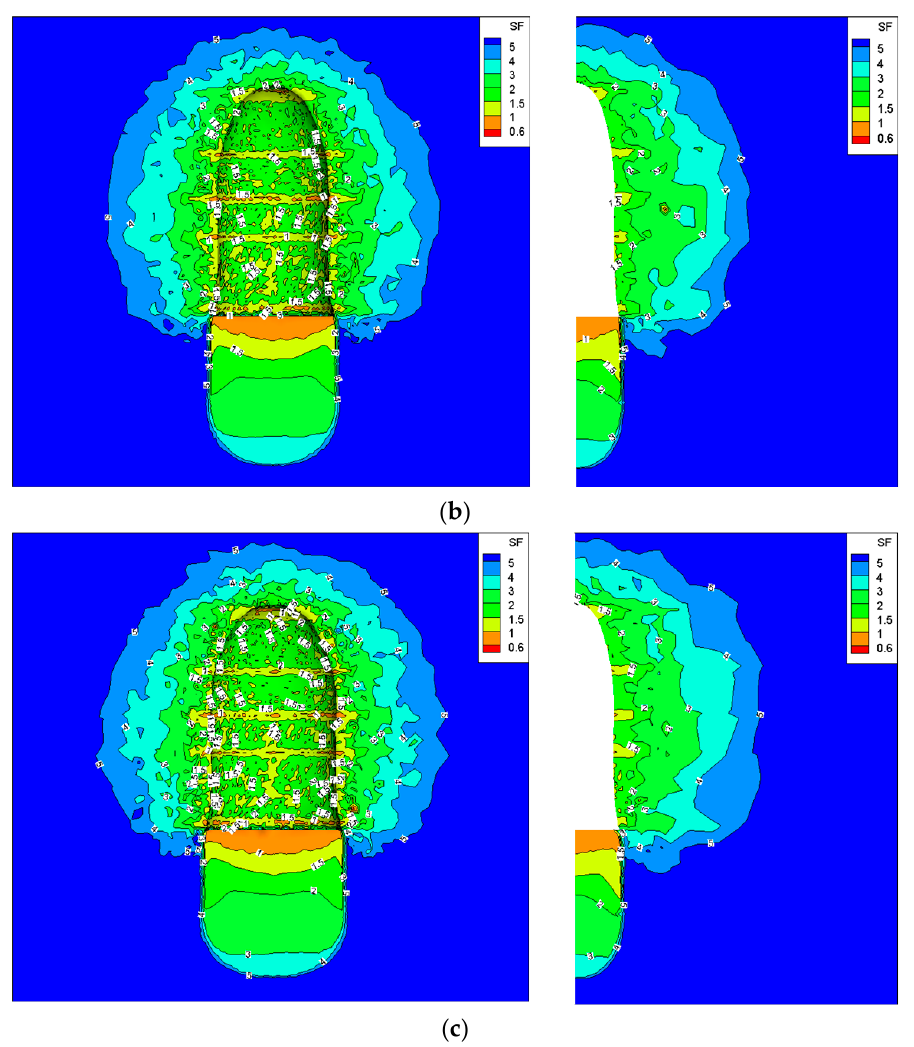
Figure 18. Dilatancy safety factor contours of the caverns with different well spacings after operating for 30 years under the internal gas pressure of 14 MPa. ( a ) 10 m, ( b ) 20 m, ( c ) 30 m.